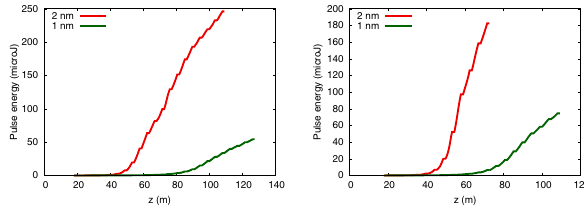
FIG. 10. EEHG gain curves with the ideal beam (left) and the S2E beam